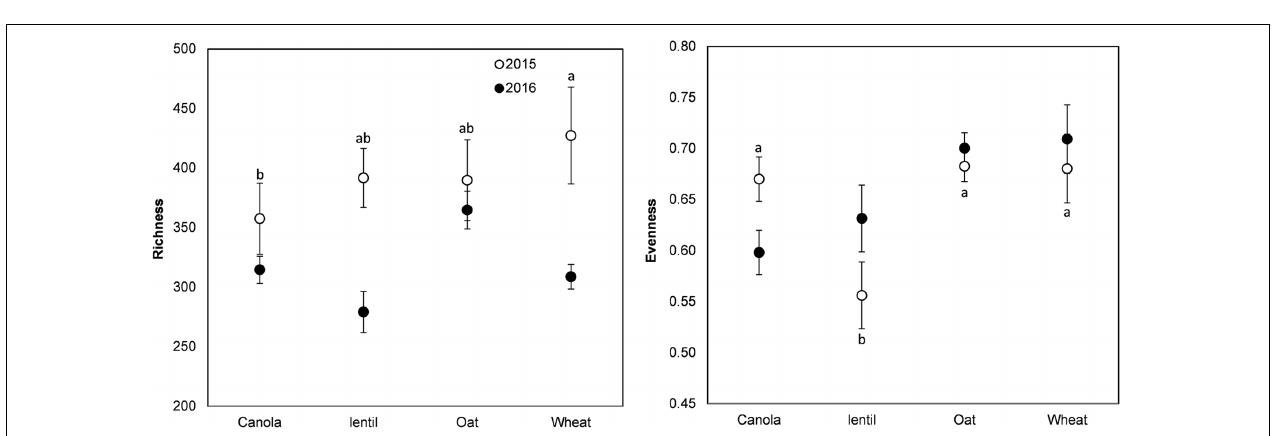
FIGURE 3 | Variation (mean ± SE) of the richness (Chao1 index) and evenness (Pielou’s index) of the fungal community of phase-4 pea rhizosphere as influenced by cropping system in 2015 and 2016. Year influenced richness ( P < 0.001), but cropping system had no significant effect. Cropping system influenced evenness in 2015. Error bars with different letters indicate a significant difference at P < 0.05, according to Tukey HSD.